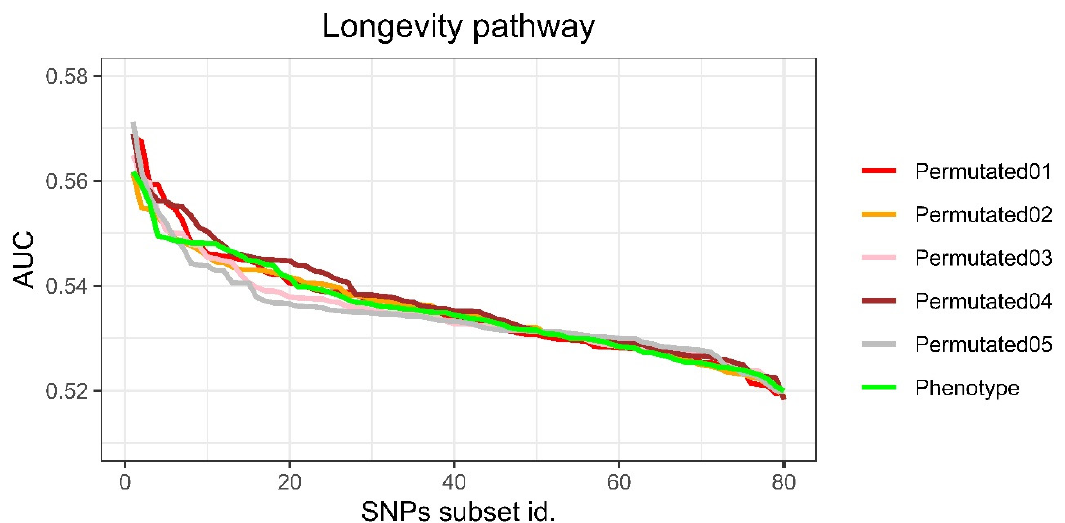
Figure 5. AUC values of the 80 iterations performed for the longevity pathway in the case of cases and controls (phenotype) and five different permutations.